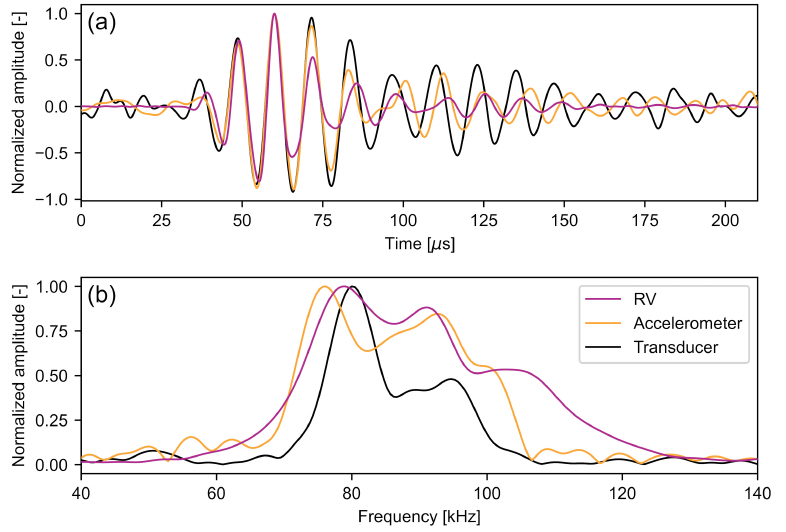
Figure 6. One pulse sensed by the various sensors with d TL = 180 mm and d LS = 90 mm in the ( a ) time domain and ( b ) frequency domain. For the signal measured by the ACU transducer, the first reflection was used so that the voltages are not capped. The signals were shifted so that their maxima